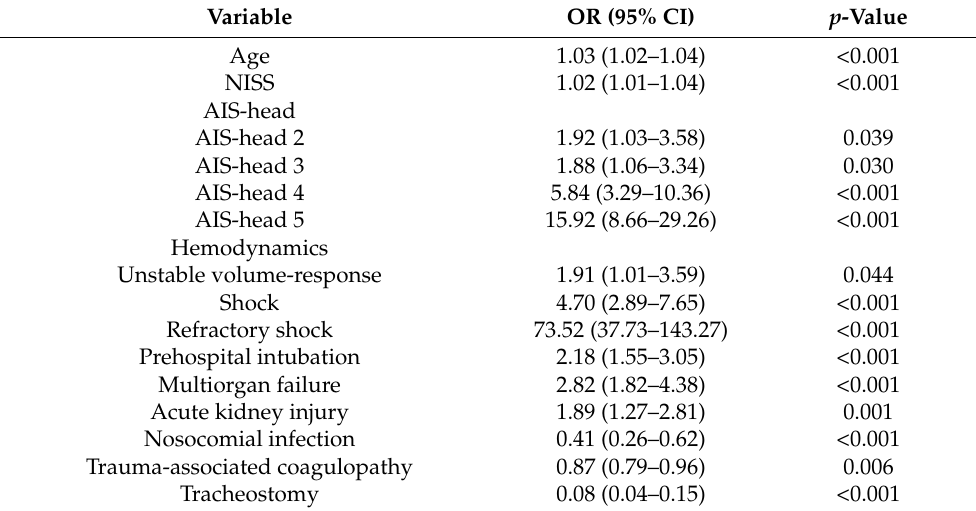
Table 6. Risk factors associated with mortality in severe chest trauma using multiple logistic regres- sion analyses.